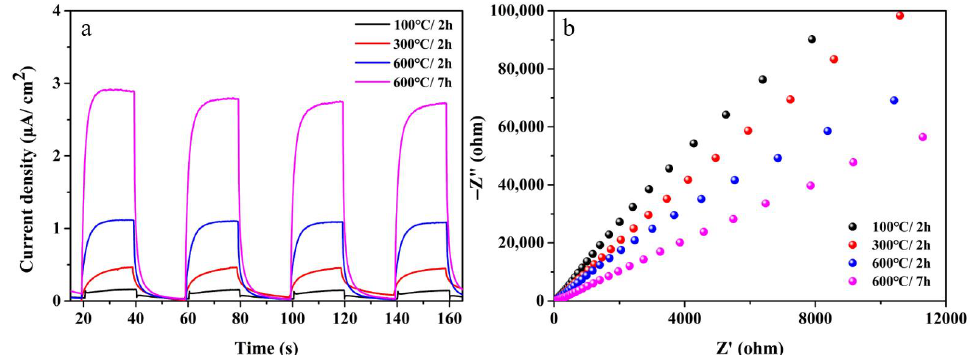
Figure 8. ( a ) Transient photocurrent response tests of all samples and ( b ) EIS Nyquist plots of all samples. Note: 100 °C/2 h, the precursor calcined at 100 °C for 2 h; 300 °C/2 h, the precursor calcined at 300 °C for 2 h; 600 °C/2 h, the precursor calcined 600 °C for 2 h; 600 °C/7 h, the precursor calcined 600 °C for 7 h.